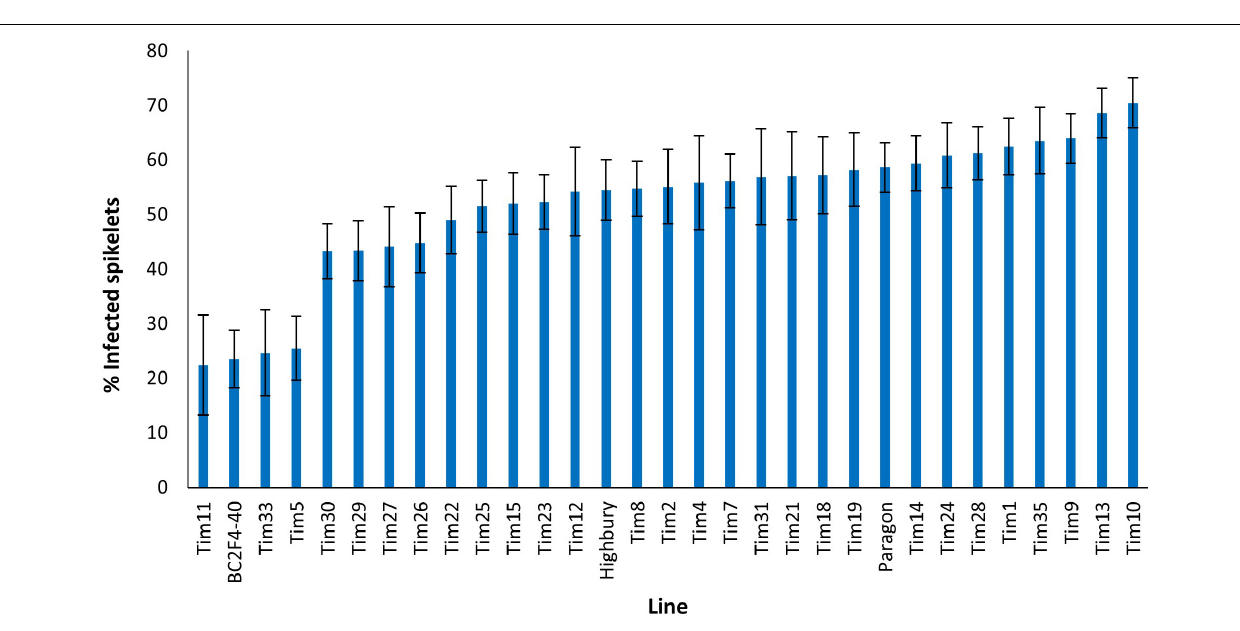
Frontiers in Plant Science |